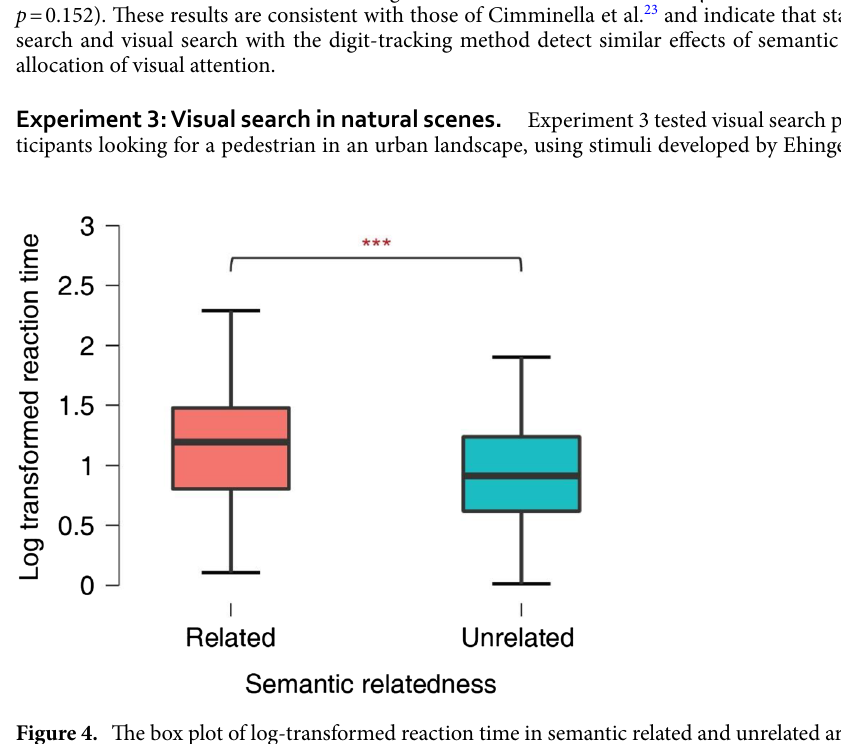
Figure 4. The box plot of log-transformed reaction time in semantic related and unrelated arrays. Participants spent more time to detect the target when the target was semantically related to the distractors, ***p <